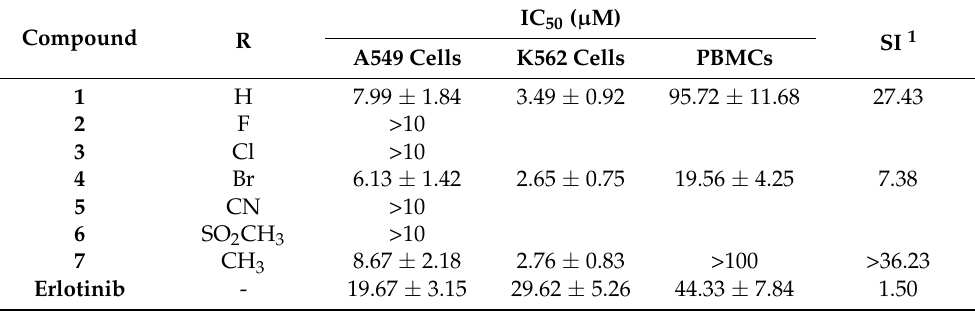
Table 1. The cytotoxic effects of the compounds on A549 and K562 cells, and PBMCs.